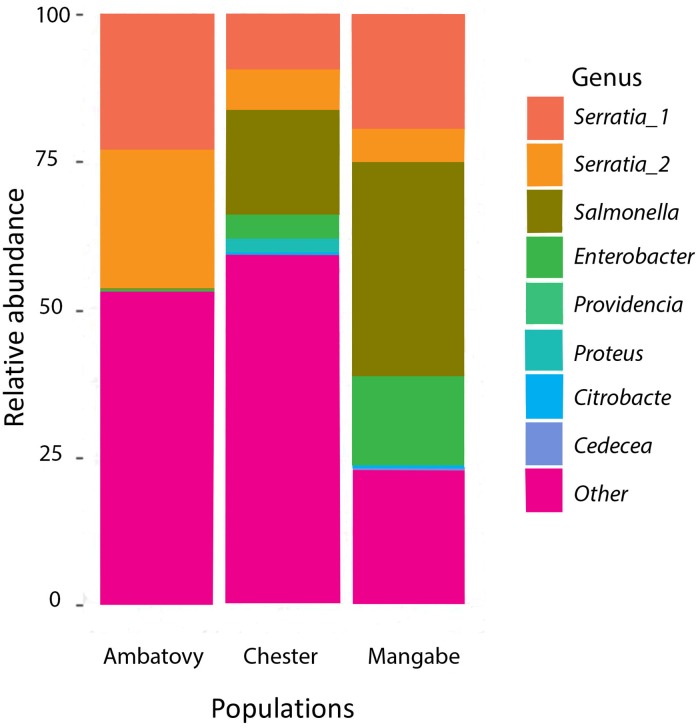
The relative abundance of sequences assigned to genera of major bacterial family (Enterobacteriacea) and all other genera observed in each of the golden mantella frog populations sampled (Chester Zoo, Ambatovy and Mangabe).